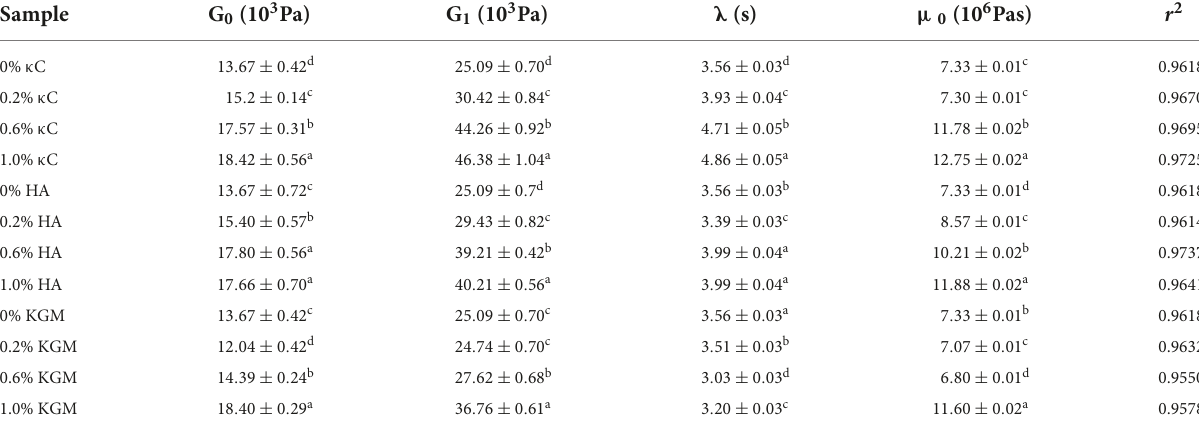
TABLE 3 The parameters of Burger’s model of emulsion gels containing different